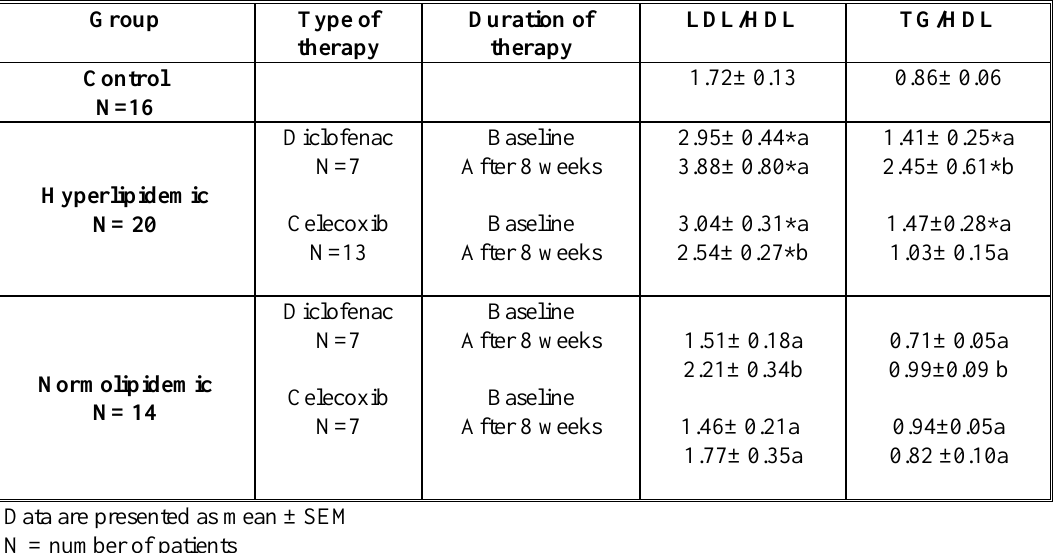
Data are presented as mean ± SEM N = number of patients